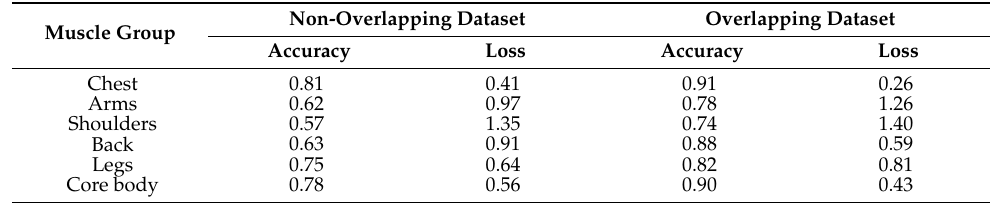
Table 4. Accuracy and loss for separate model of each muscle group.